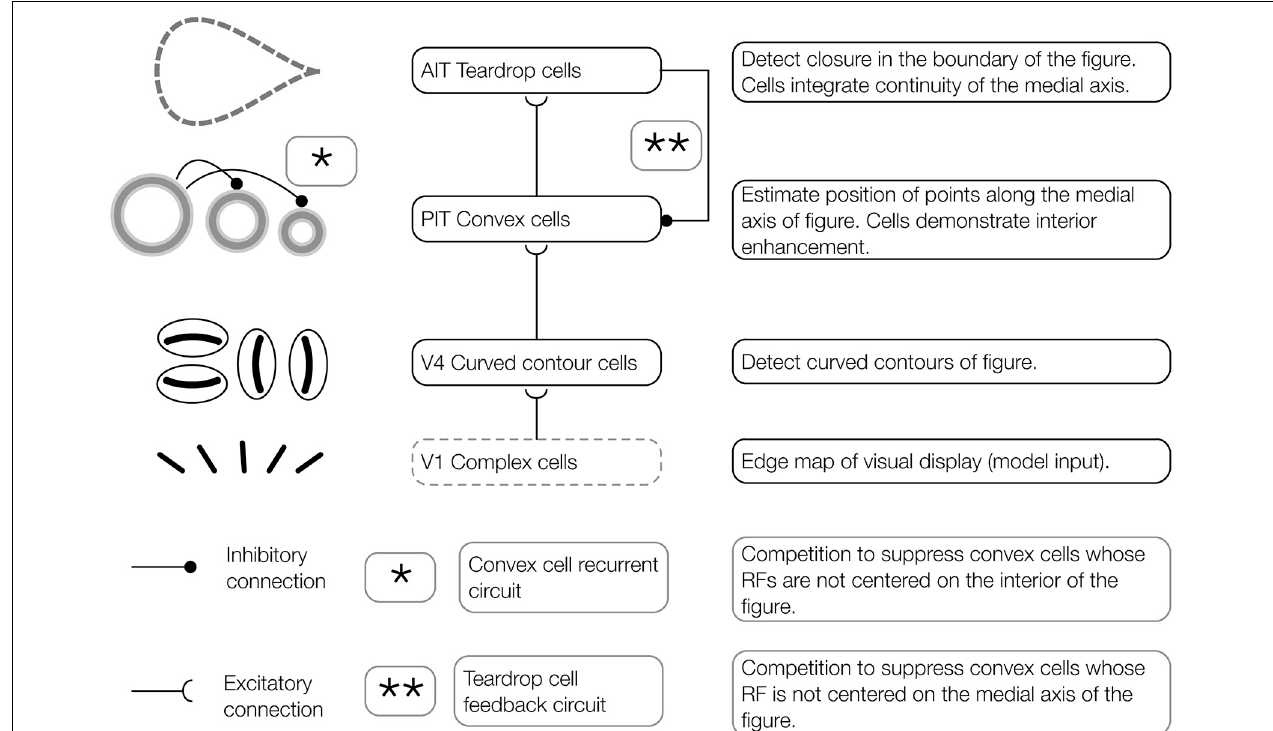
FIGURE 3 | Architecture of the proposed model of figure-ground segregation. Convex cells in the model demonstrate interior enhancement when their RFs are centered along the medial axis of a figure. Preprocessed edge maps of each visual display serve as input to the model. The input contains the edges of potential figures and roughly corresponds to the output of complex cells in primate V1. In the first model layer, curved contour cells detect the curvature of edges in the visual display. Curved contour cells project to convex cells in the second model layer, which possess on-surround, annulus-shaped RFs. Convex cells respond when the boundary contours of a figure enter the parameter of the circle depicting the RF. These units are ideally suited